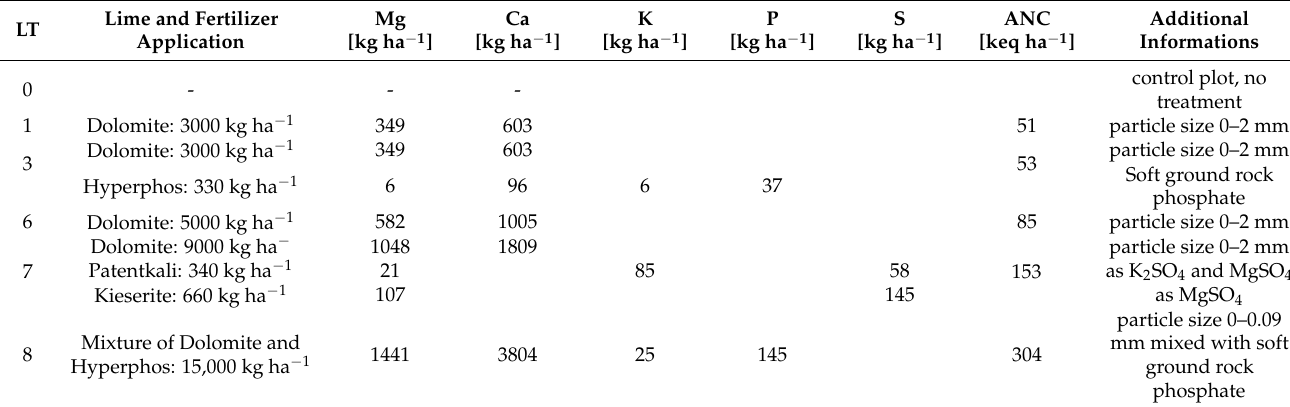
Table 2. Liming treatments (LT) of the three study areas. Lime and fertilizer were applied in December 1988. Patentkali is a potash fertilizer containing potassium sulfate and magnesium